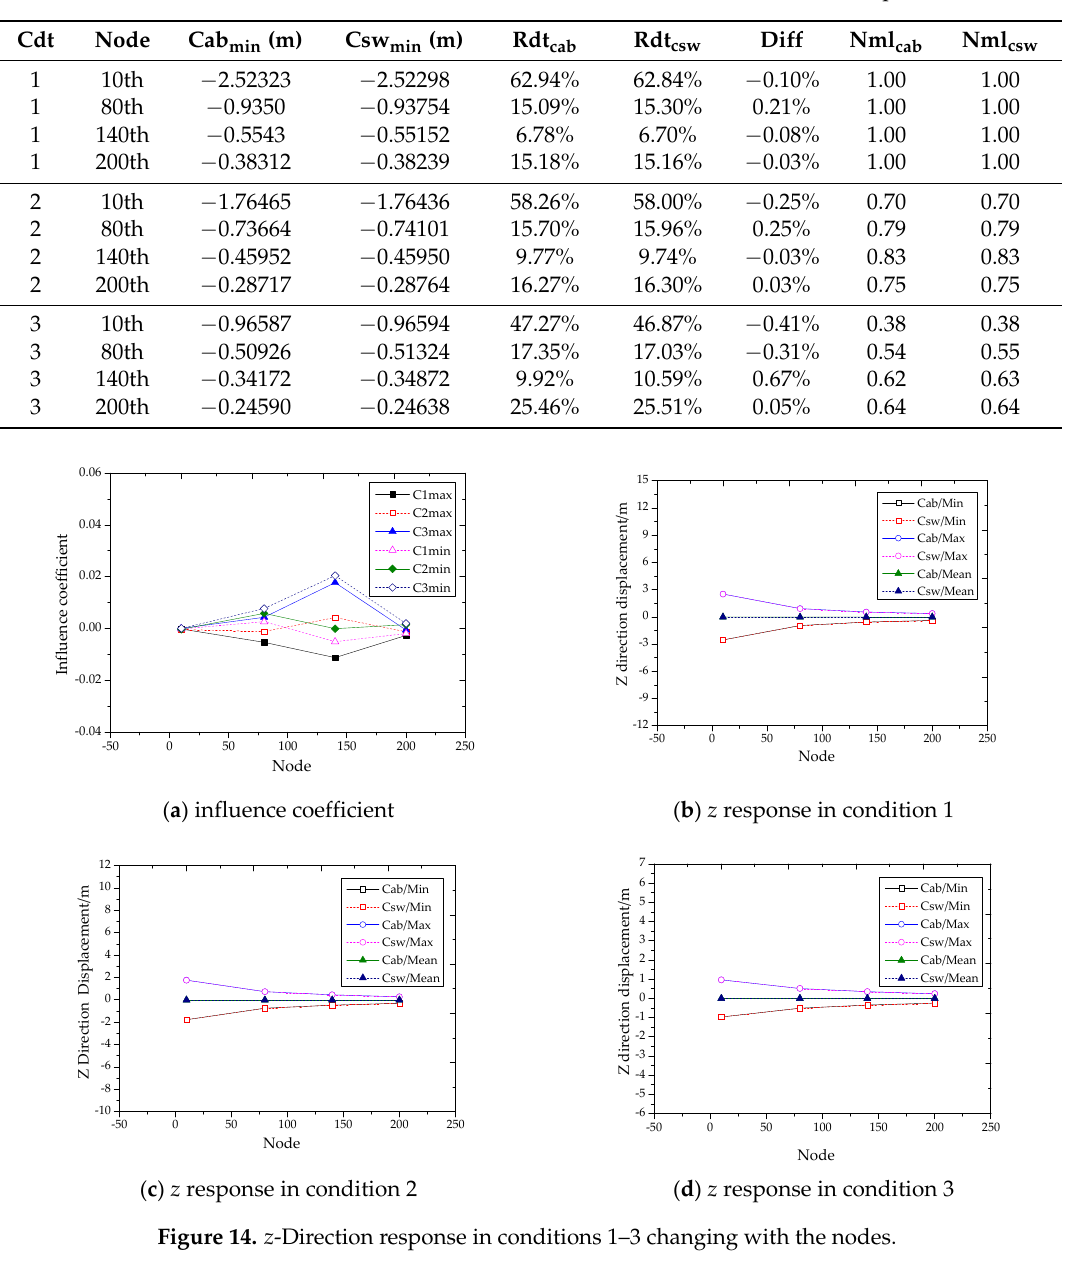
Table 10. Reduction, difference and normalized values of node’s minimum response.